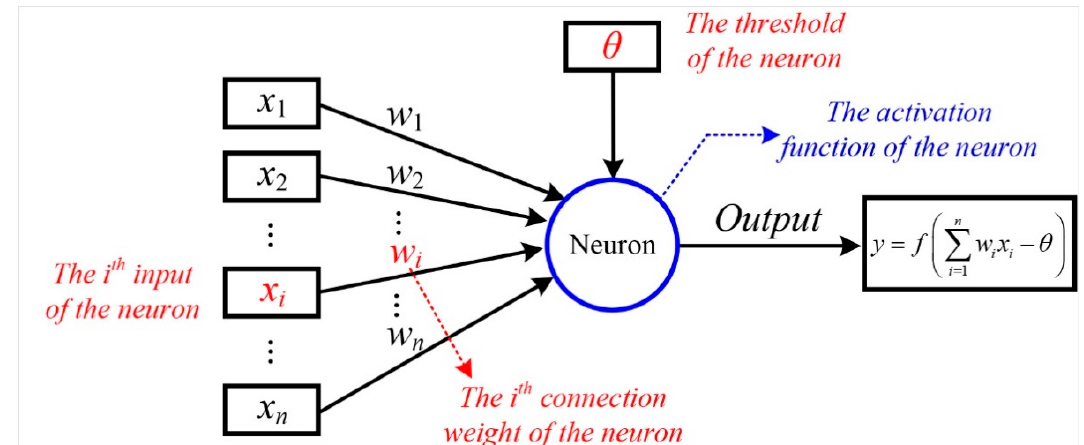
Figure 4. The M-P neuron model.